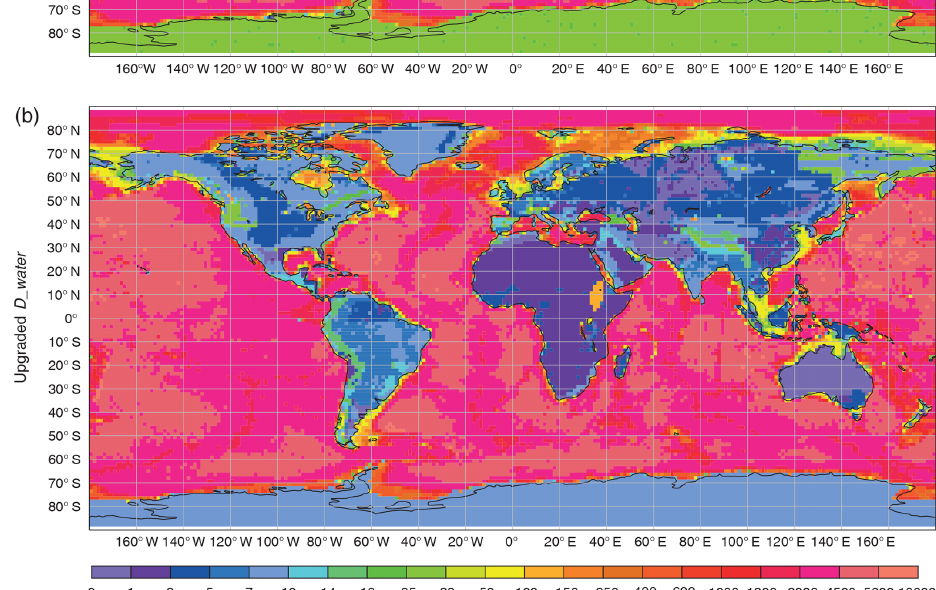
CY43R3 model on the triangular cubic octahedral grid